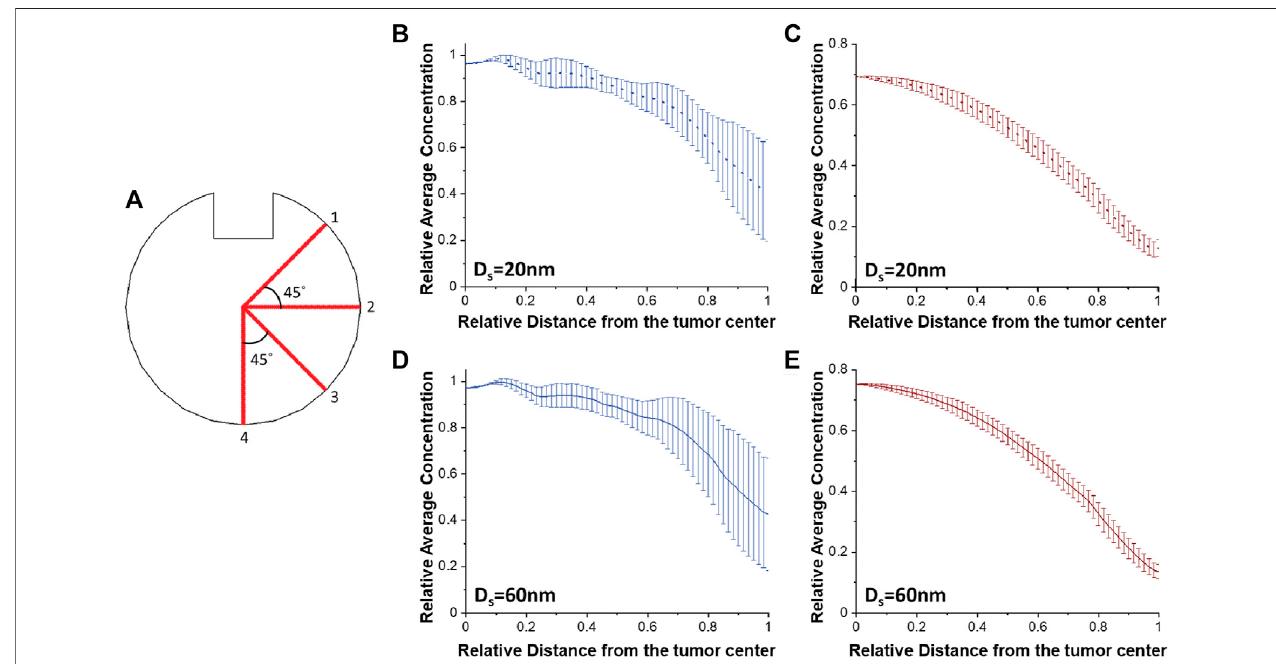
FIGURE 7 | Heterogeneity of drug distribution within tumor tissue. (A) Schematic representation of four different directions in the plane for calculating both the average concentration of the drug and the standard error. Plots of the average concentration calculated along the four directions as a function of the distance from the tumor center (B,D) after 5 h and (C,E) after 9 h, for baseline tumor microenvironment conditions, and for different drug diameters: (B,C) 20 nm and (D,E) 60 nm. Drug concentration is normalized by division with the reference value entering the catheter. Distance is normalized by division with the tumor